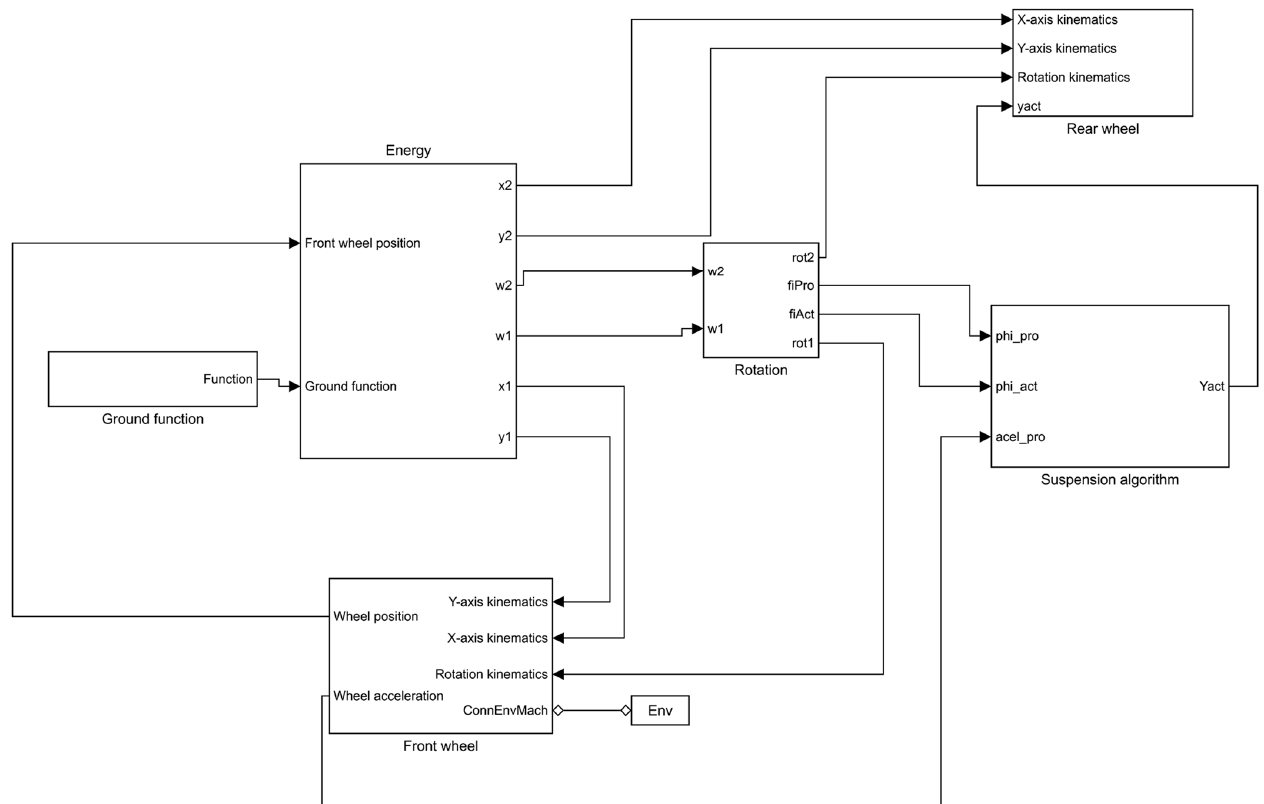
Figure 8. Diagram of the Simulink implementation of the whole